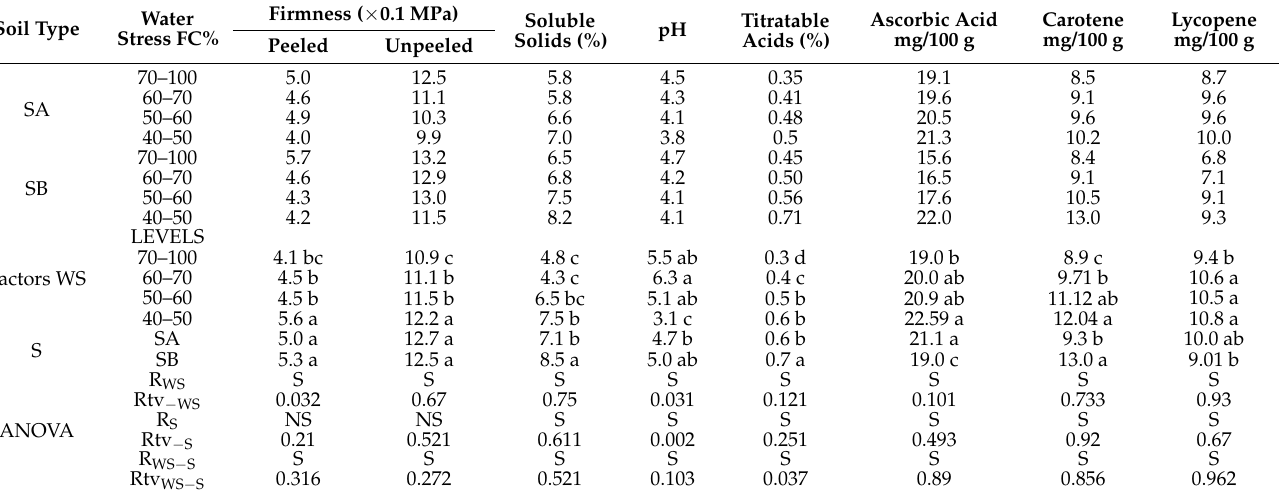
Table 8. Tomato firmness, soluble solids, pH, total acids, ascorbic acid, carotene, and lycopene contents under different water stress levels and in sandy loam and silty loam